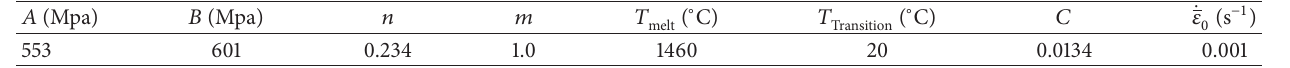
Table 1: The Johnson-Cook model characteristics parameters of AISI-1045 steel [7].